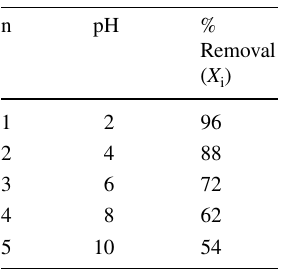
Fig. 2 a 3D surface plot of response ( Y ) vs adsorbent dosage ( X dosage ( X 1 ) and pH ( X 3